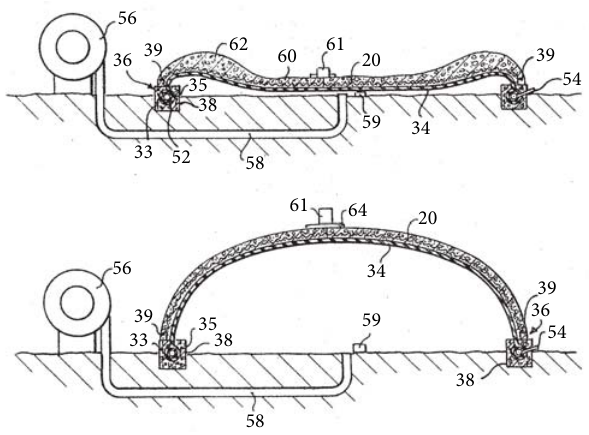
Figure 7: Bini’s shell construction method